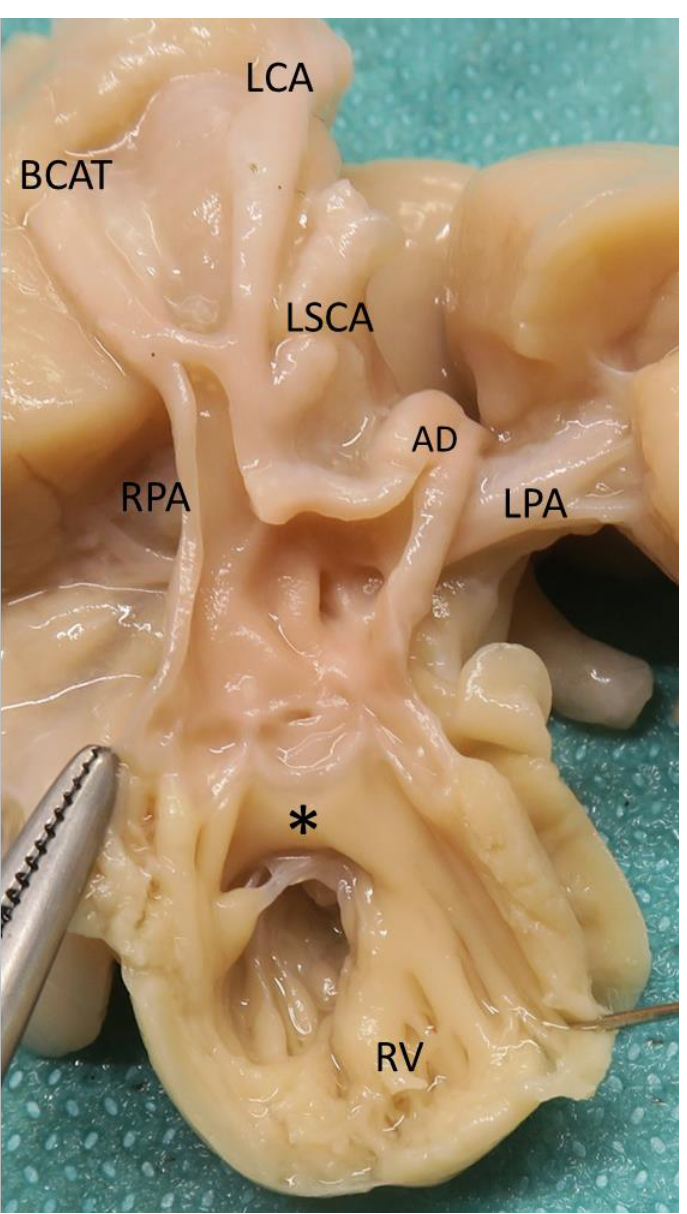
Figure 5. Heart specimen with common arterial trunk type 4, interruption of the aortic arch type A, left aortic arch, and hypoplastic left ventricle (Table 3, Case 36). View from the right ventricle. The common arterial trunk (CAT) is entirely above the right ventricle and there is a subarterial conus (asterisk). AD, arterial duct; BCAT, brachiocephalic arterial trunk; LCA: Left carotid artery; LPA, left pulmonary artery; LSCA, left subclavian artery; RPA, right pulmonary artery; RV, right ventricle.